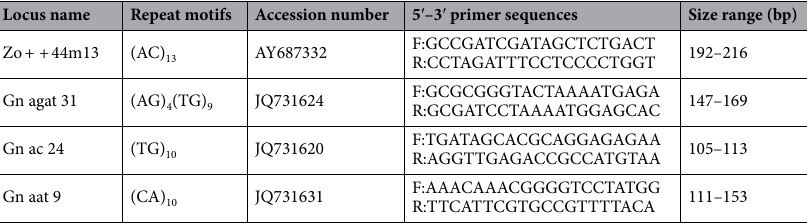
Table 1. Genetic characterisation of the 4 microsatellite loci used in this study. The table shows locus name, repeat motifs, Genbank accession numbers, sequences of forward (F) and reverse (R) primers, allelic size range 44,45